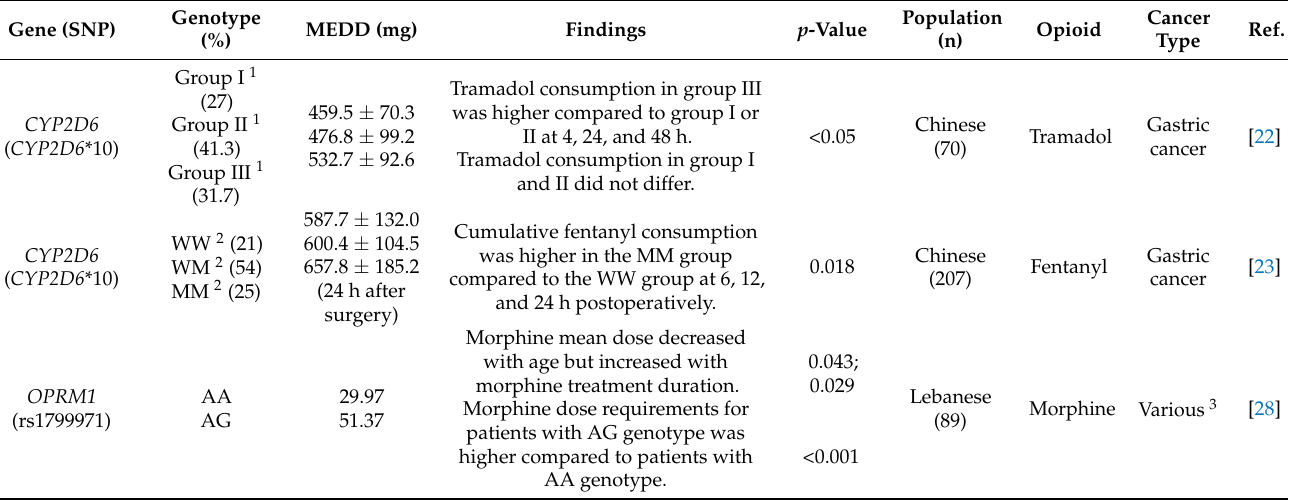
Table 4. Polymorphisms significantly associated with opioid dose requirements in cancer pain among Asian